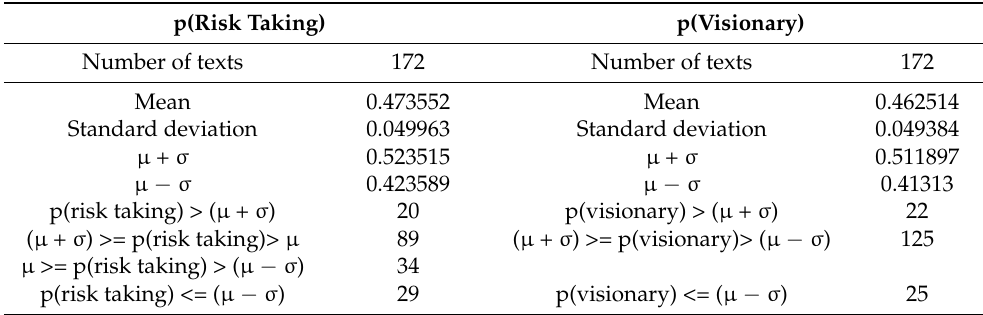
Table 9. The results of the bivariate correlation analysis for p(risk taking) and p(visionary). Correlations p(risk taking) p(visionary) PearsonCorrelation 1 0.818 ** p(risk taking) Sig. (2-tailed) 0.000 N 172 172 PearsonCorrelation 0.818 ** 1 p(visionary) Sig. (2-tailed) 0.000 N 172 172